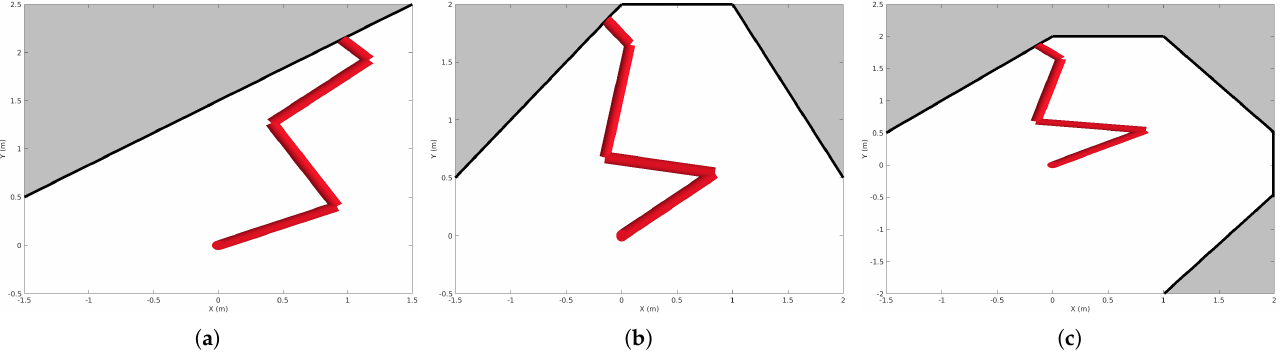
Figure 1. Workspaces for simulation experiments. Experiment I ( a ), Experiment II ( b ) and Experiment III ( c ). The manipulator fixed base is located at the ( 0,0 ) coordinates. The dark grey sections define the obstacle walls, with its surface identifying the contact line to be tracked by the manipulator end